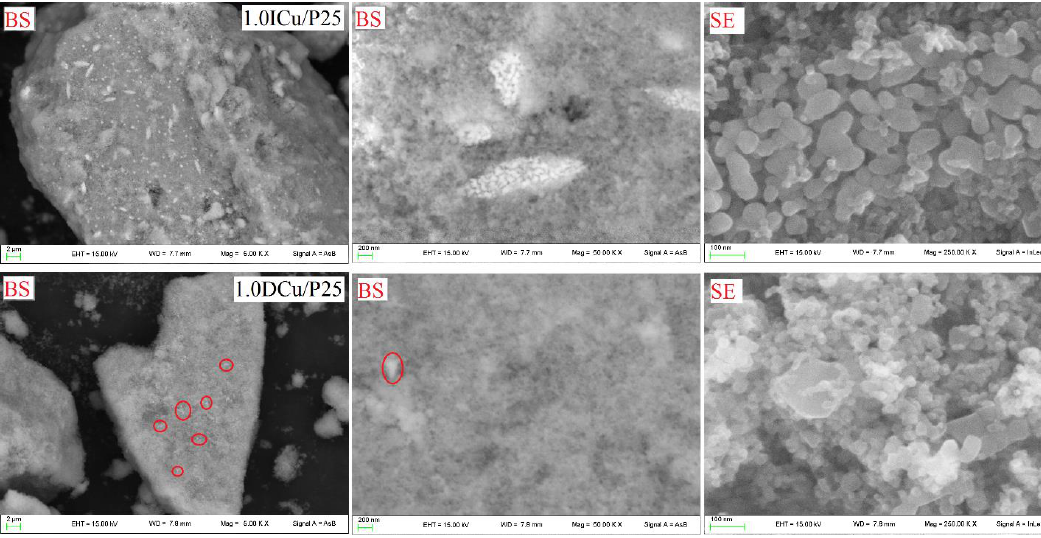
Figure 7. Scanning electron microscope (SEM) micrographs of 1.0ICu / P25 (top) and 1.0DCu / P25 (bottom). In each line, the first two pictures report Back Scattered (BS) electrons (marker 2 µ m and 200 nm), the last reports Secondary Electrons (SE) (marker size 100 nm)